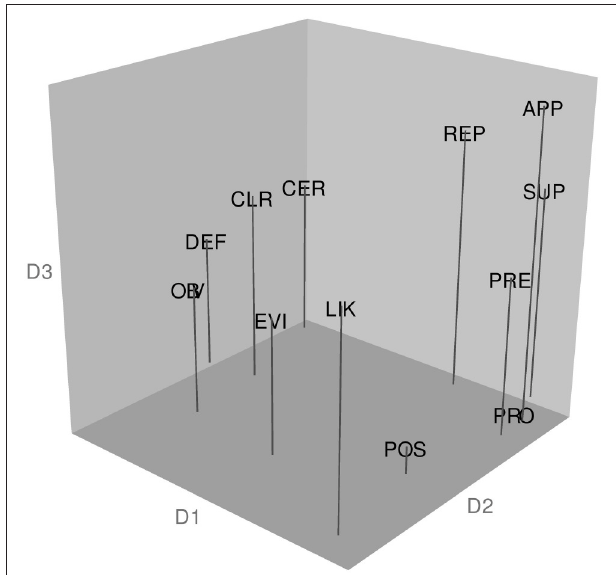
FIGURE 2 | Configuration of target adverbs in the Australian sample and the results of a hierarchical cluster analysis of the coordinates from the MDS spatial configuration. The abbreviations for the 12 target adverbs are: APP, apparently; CER, certainly; CLR, clearly; DEF, definitely;